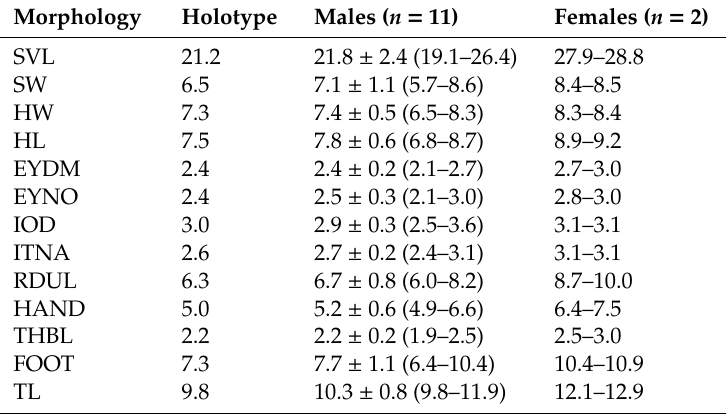
Figure 6. Coloration of the dorsal (upper images) and ventral (lower images) surfaces of the holotype and three males of type series of Atelopus manauensis sp. nov. recently euthanized: ( A , E ) INPA-H 041378, ( B , F ) INPA-H 041365, ( C , G ) INPA-H 041367, ( D , H ) INPA-H 041369. Note the reticulated network on the dorsum of each individual is unique; the variation in the distribution of the red spot on the thighs and posteroventral portion of the cloacal region; and the entirely white venter or white with a cream-colored gular region and head. Table 4. Morphometric measurements of the holotype and type series of Atelopus manauensis sp. nov. Measurements of the holotype, followed by mean, standard deviation, and maximum–minimum in parentheses for 11 adult males. Measurements of the two females are presented in the last column. Abbreviations for morphometric measurements are described in Material and Methods. Abbreviation: ( n ) sample